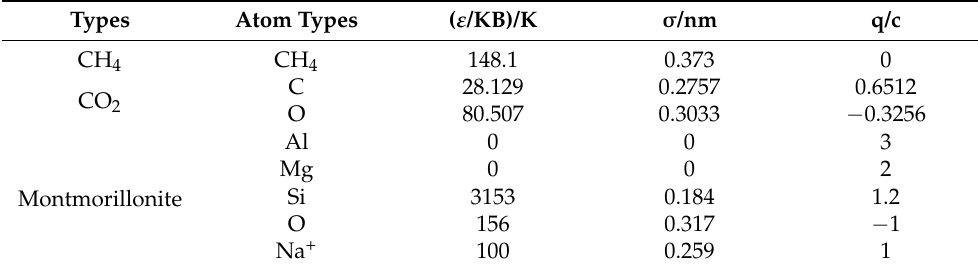
Table 2. Potential energy parameters and charges of each atom [32] Reproduced with permission from Wang J, Acta Mineral. Sin.; published by the Chinese Academy of Sciences,